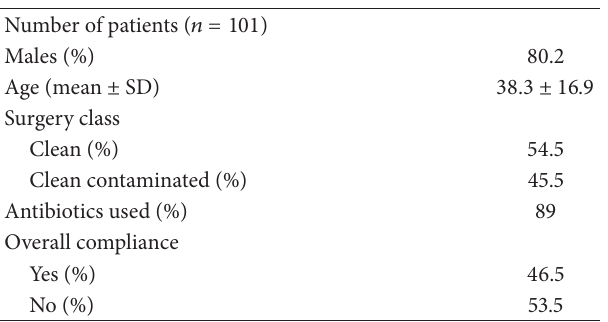
Table 1: Overview of demographics and surgical antibiotic prophy- laxis.